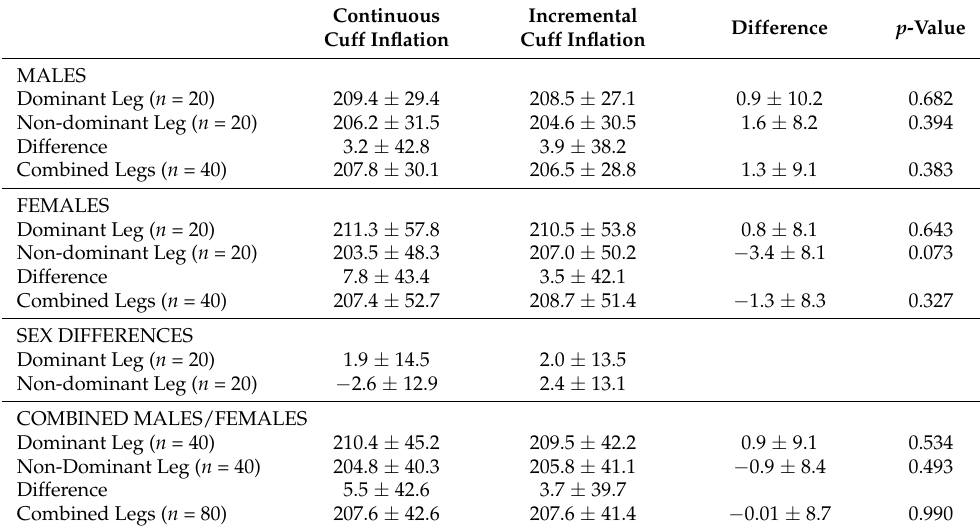
Table 3. Arterial Occlusion Pressure Using Two Cuff Inflation Protocols.